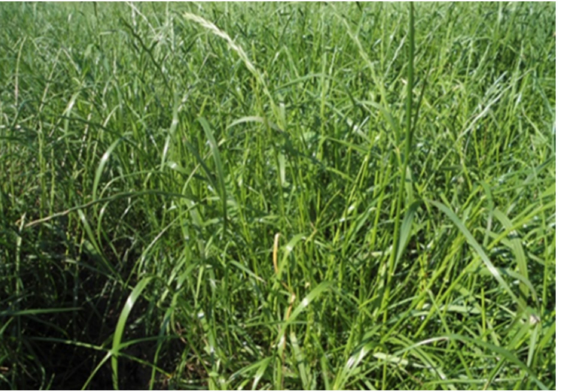
Figure 6. Perennial ryegrass ( Lolium perenne L.) Variety Tetramis. Author’s photos of Prof. A. Katova.